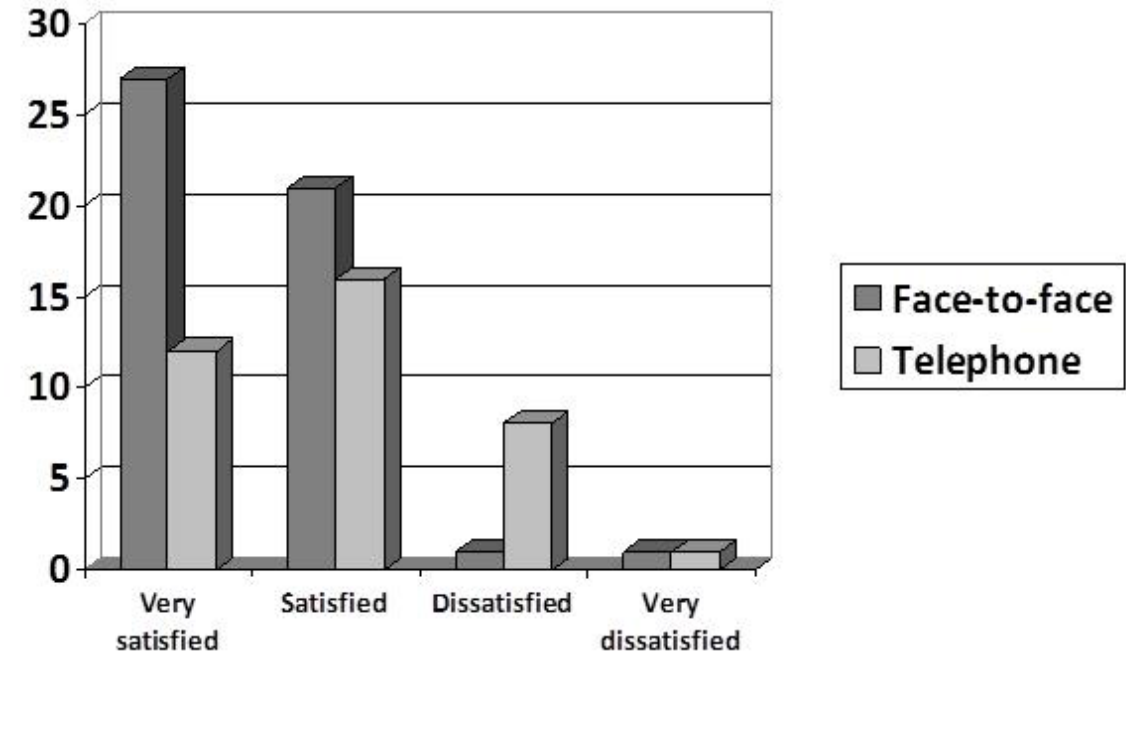
Figure 1. Parent (N = 50) satisfaction with current communication methods with child's health care